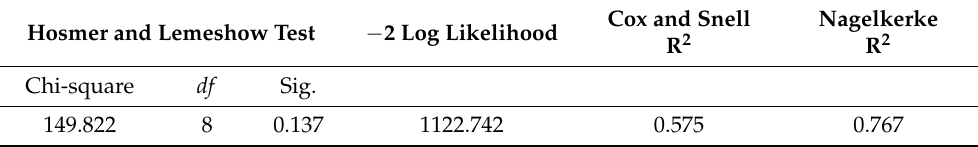
Table 5. Overall statistics of the logistic regression model. Hosmer and Lemeshow Test